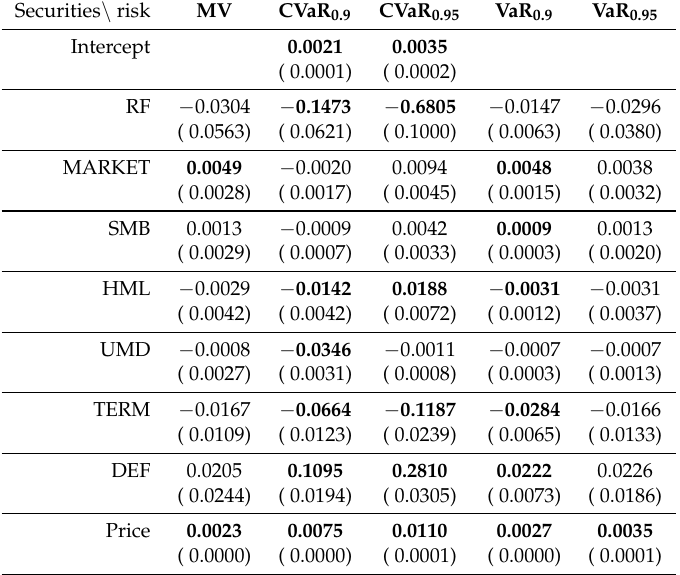
Table 2. Hedging of Real Interest Rate. The table reports the estimates and their corresponding bootstrap errors (based on 400 bootstrap replications) for different risk measures (mean-variance MV, conditional value-at-risk CVaR, and value-at-risk VaR). The bold font represents statistical significance (at the 5% nominal level) of individual coefficients except for the last row where the bold font signifies a statistically different price from E ( y )